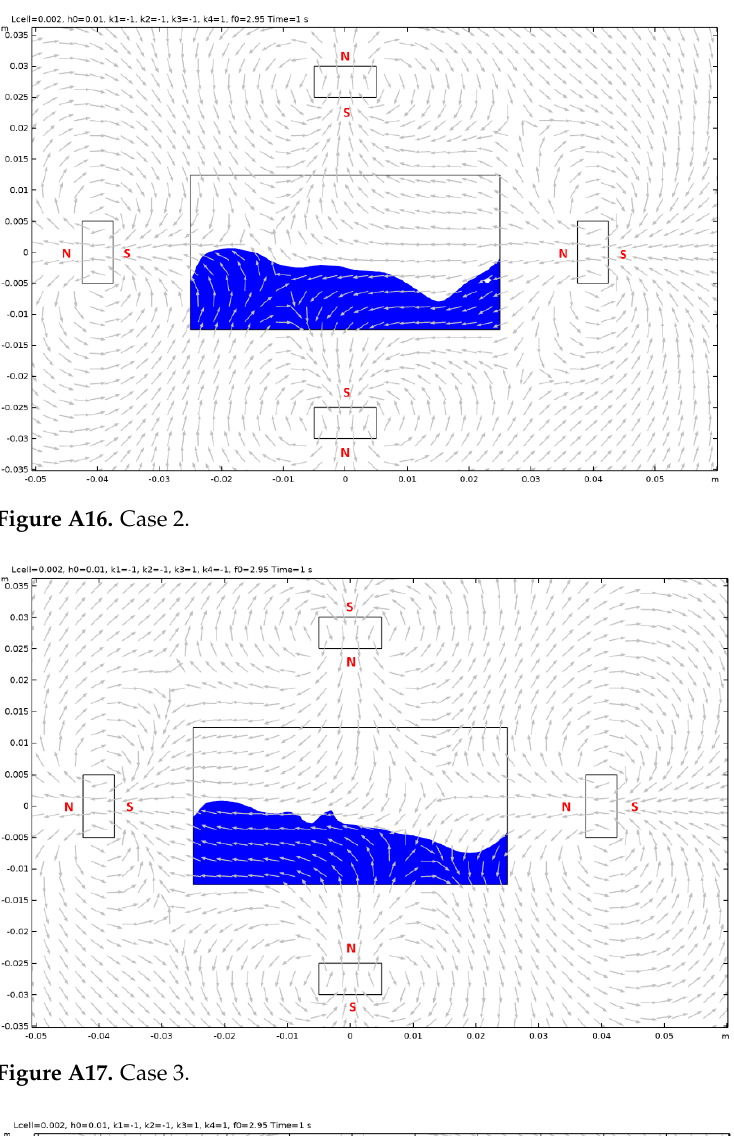
Figure A15. Case 16.